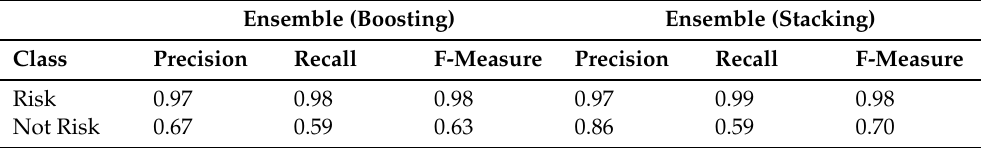
Table 3. Class-wise comparison of Ensemble classifier by Boosting and Stacking without Feature Selection.